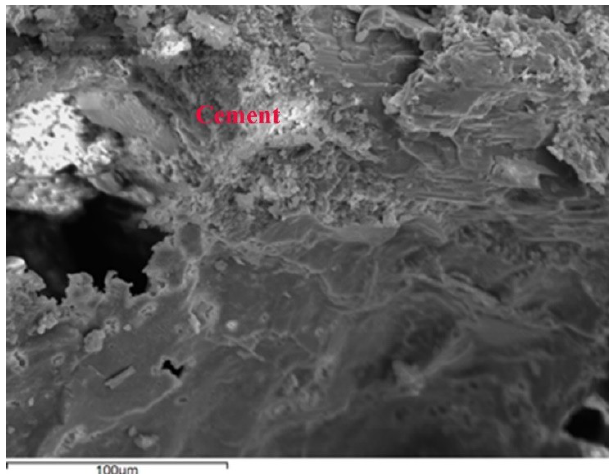
Figure 14. SEI image of beachrocks collected at area 2 indicating cement morphology. Minerals 2018 , 8 , x FOR PEER REVIEW